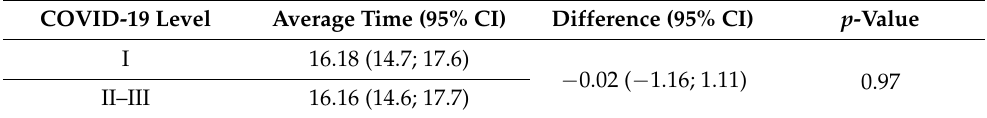
Table 6. Average number of days of absence due to SARS-CoV-2 infection. COVID-19